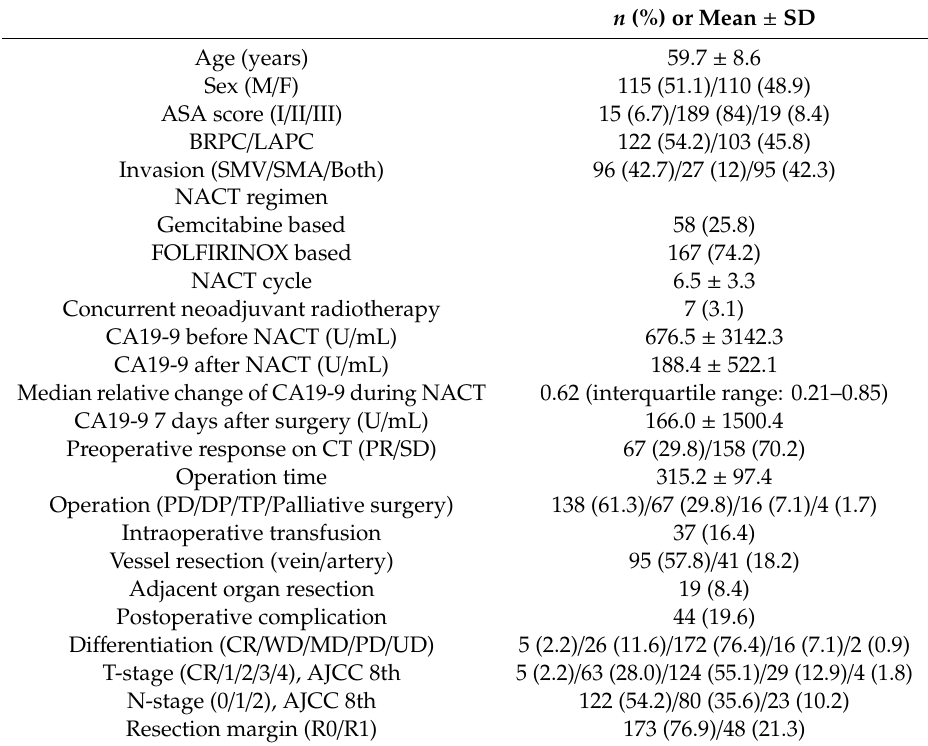
Table 1. Patient characteristics ( n = 225).